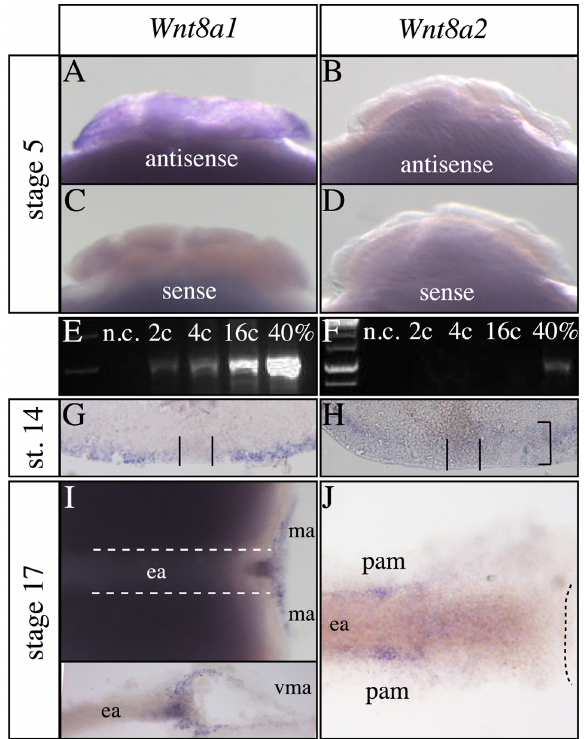
Figure 2. Differential early Wnt8a1 and Wnt8a2 gene expres- sion. (A–D) 8-cell stage embryos are shown with the animal pole to the top. Sense RNA probes were used to validate the maternal Wnt8a1 expression. (E,F) RT-PCR for Wnt8a1 and Wnt8a2 transcripts on extracted RNA at stages indicated to the left. (G,H) Pictures focused on the dorsal margin of the dissected blastoderm of embryos at 40% epiboly with animal pole to the top. While Wnt8a1 (G) is expressed in cells of the blastoderm margin but not in cells of the shield (framed by black lines), Wnt8a2 (H) is weakly expressed in cells of the shield and the margin. Open rectangle indicates the broad Wnt8a2 expression domain at the margin. (I,J) Embryos at 80% epiboly with anterior to the left; (I) dotted lines frame the developing embryonic axis; inset and (J) show embryos dissected from the yolk for clarity. (J) Dotted line marks the blastoderm margin. 40%, 40% epiboly; c, cells; ma, margin; ea, embryonic axis; n.c., negative control; pam, paraxial mesoderm; st., stage; vma, ventral